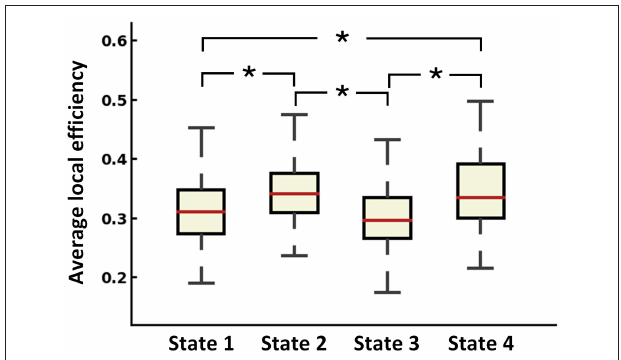
FIGURE 3 | Average local efficiency of dFC states across all subjects. * p < 0.05 after FDR corrected.